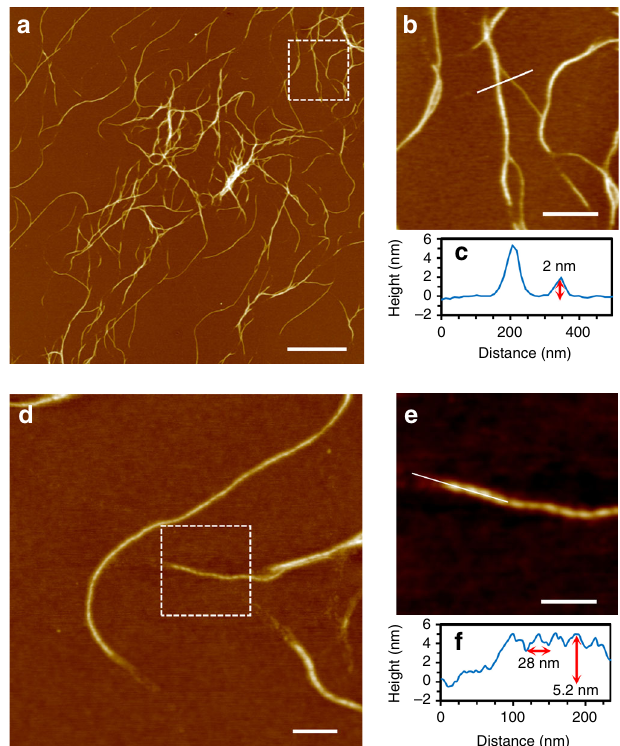
Fig. 1 AFM images of Au-thioguanosine xerogel 1 drop-cast onto a silicon wafer. Large-scan ( a ) and a zoom area ( b ) of AFM height images of 1 . The associated cross-section ( c ) along the white line in b . AFM height images ( d , e ) showing the helical structure of individual molecular chains. The associated cross-section ( f ) along the white line in e . Scale bar is 2 µ m in image a , 500 nm in image b , 200 nm in image d , and 100 nm in image